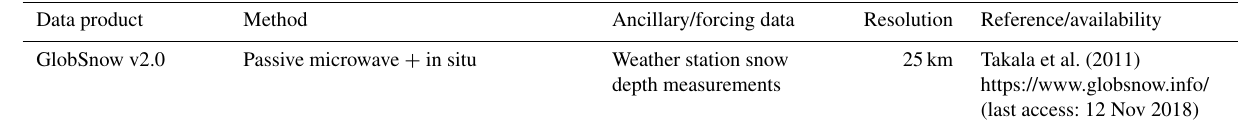
Table 1. Summary of SWE products evaluated in this